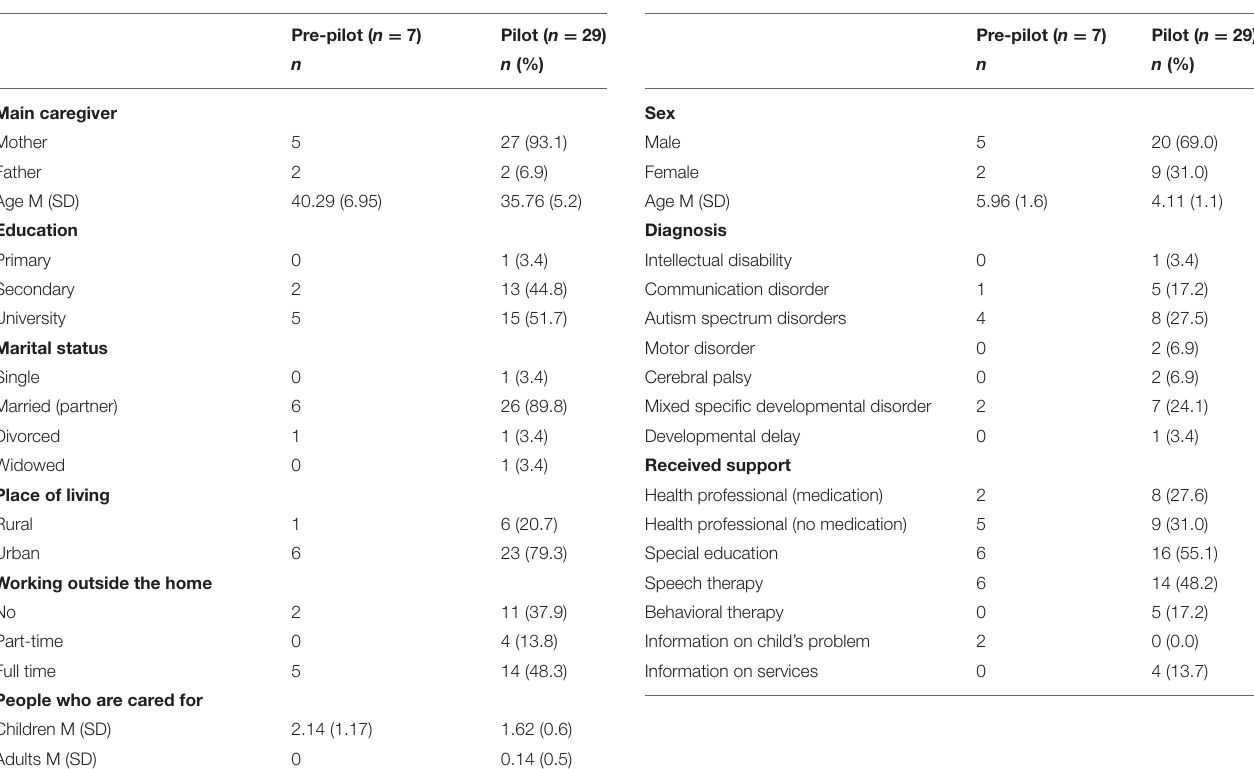
TABLE 1 | The socio-demographic data of caregivers. TABLE 2 | The demographic data of